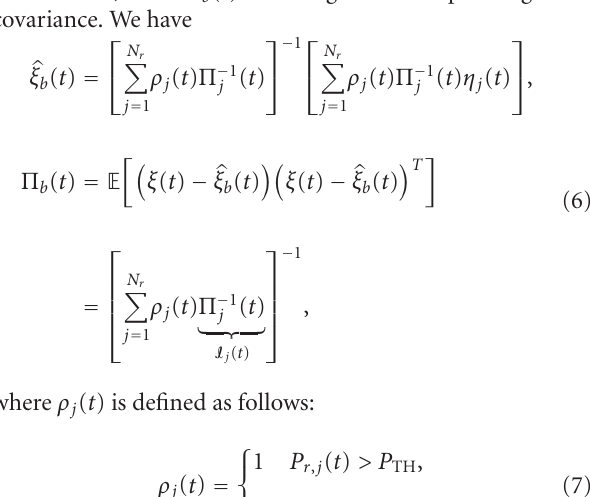
the position of the target at time t , after fusing all the received information, with Π b ( t ) denoting the corresponding error covariance. We have